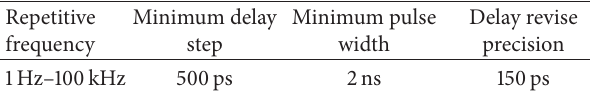
Table 2: Technical parameters of homemade TCU. Repetitive